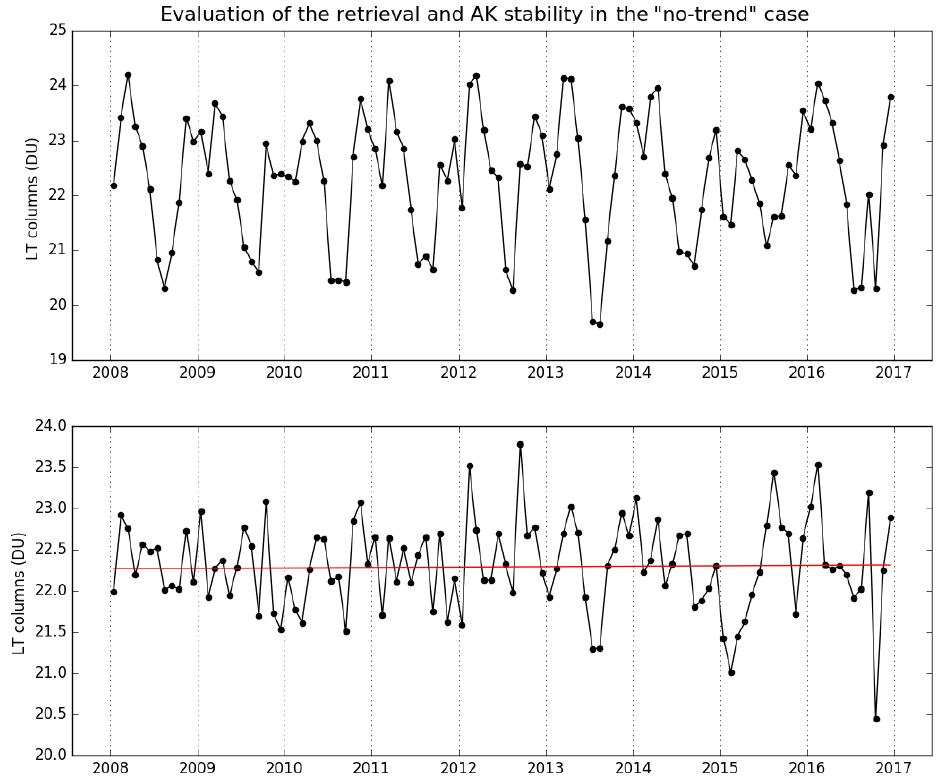
Figure 3. Monthly time series (top) and its associated deseasonalized time series and linear trend calculated for a unique ozone profile smoothed by each individual averaging kernel (AK) of IASI over the NCP between 2008 and 2016. Table 1. Statistics of the IASI and ozonesondes comparisons Sonde